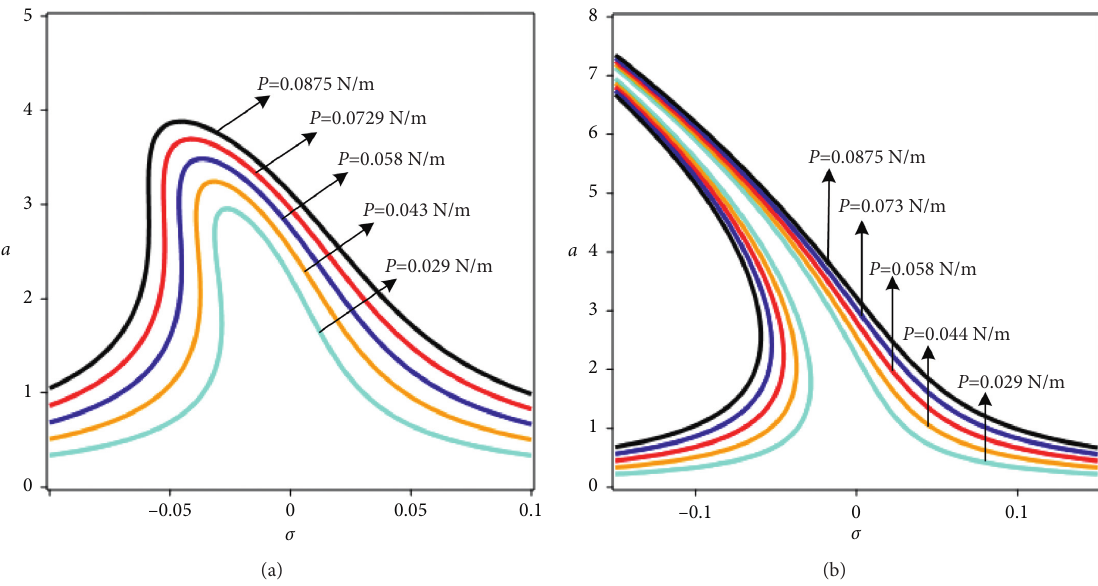
Figure 10: The amplitude-frequency response curve of primary resonance (varied P ) (a) considering aerodynamic force; (b) without considering aerodynamic